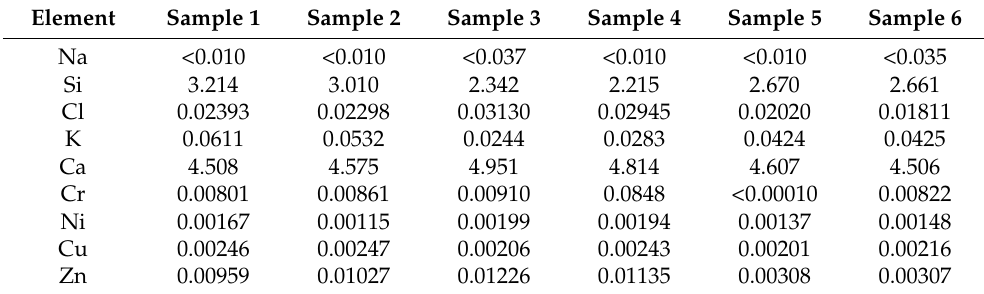
Table 2. Elements obtained in stormwater samples (concentration, %) (Antaviliai, Vilnius Region).